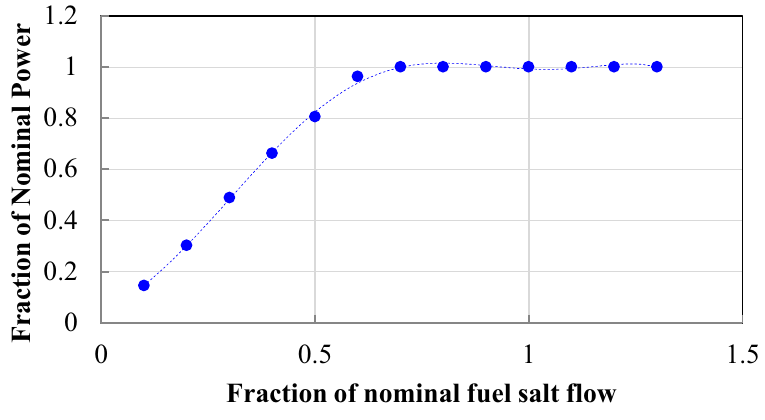
Figure 5.2. Flow rate influence on output